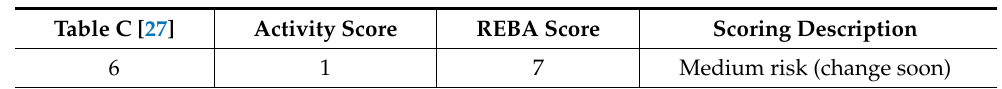
Table 7. REBA score before